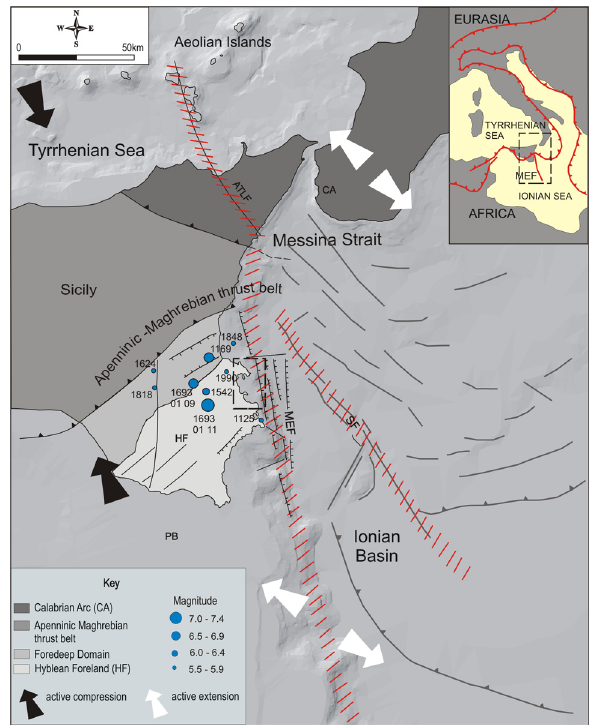
Figure 1. Structural map of eastern Sicily showing the main do- mains and structural elements: the Apenninic-Maghrebian Thrust Belt, the Hyblean Foreland (HF) affected by faults and bounded by the Malta Escarpment (MEF) connecting HF to the Ionian Basin. Circles are the epicentres of the strong historical earthquakes [CPTI Working Group 2004]; arrows indicate active contraction and extension (modified from Palano et al. 2012); dashed lines are the two belts of active deformation of the Ionian Sea proposed by Palano et al. [2012]: MEF and the STEP Fault (SF) according to Polonia et al. [2011]; the dashed line rectangle delimits the Augusta Bay shown in Figure 2. Inset shows the Africa-Eurasia plate con- figuration, rectangle shows the location of Figure